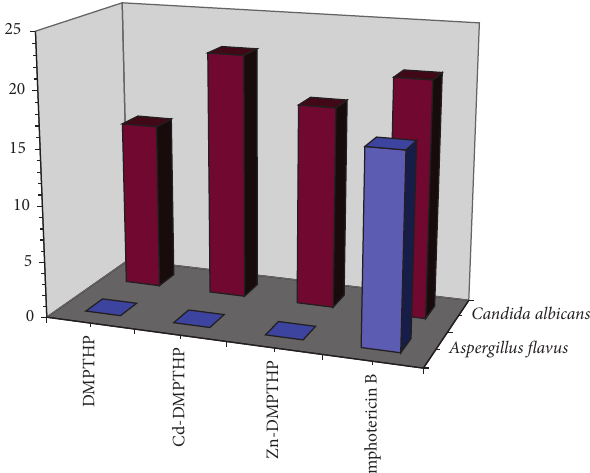
Figure 4: Antifungal activity of the synthesized